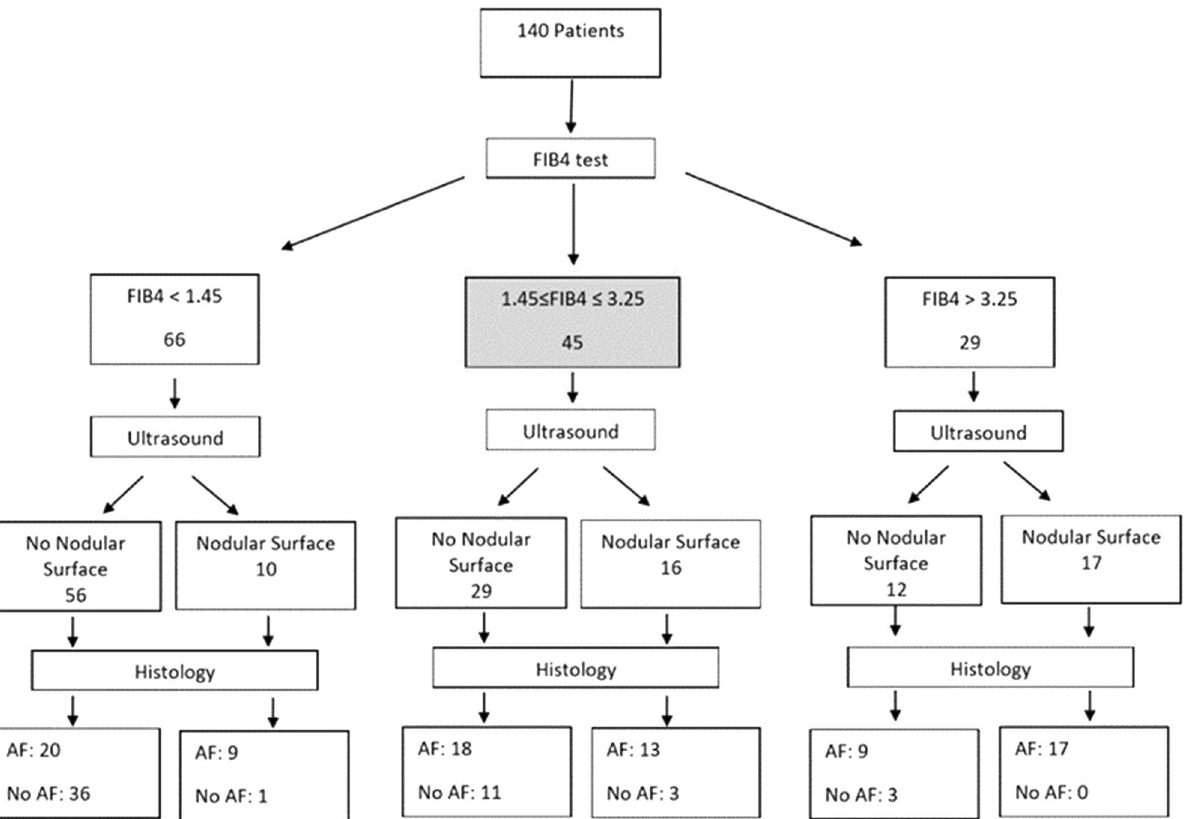
Figure 1. Algorithm 1: Non-invasive approach using FIB-4 and US for assessment of advanced fibrosis in patients with chronic liver